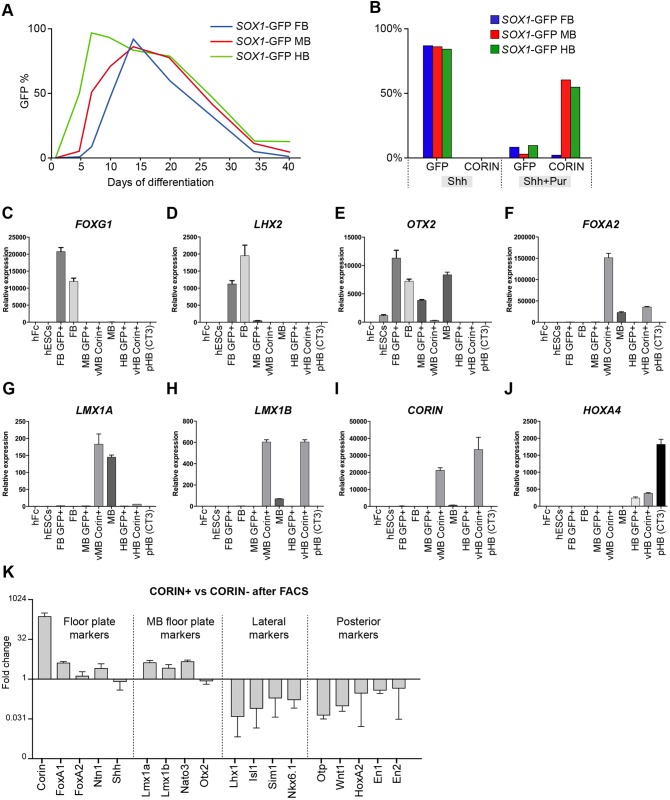
Isolation of purified regionalized human neural progenitor cells. (A) The optimal time point for isolation of early patterned neural progenitors was decided by monitoring the expression of GFP by FACS upon neural differentiation for 40 days. The GFP expression in FB and MB NE cells peaked at day 14, whereas the GFP expression of HB NE peaked already at ∼day 6 and stayed high until terminal differentiation was initiated at day 16. (B) Cells were analysed by FACS at day 14 of differentiation. The vast majority of NE cells express GFP, whereas the FP marker CORIN is absent. In order to ventralize the cells effectively, the SHH agonist Purmorphamine (Pur) was added to the media, in addition to SHH, during day 0-9 of differentiation, resulting in the majority of cells being GFP– at day 14, and FP cells from MB and HB cultures starting to express high levels of CORIN. (C-J) Regionalization of SOX1-GFP ESCs patterned towards FB, MB or HB was investigated at day 14 using qRT-PCR. FB patterning was analysed by the expression of FOXG1, LXH2 and OTX2. MB patterning was analysed by the expression of OTX2, FOXA2 and LMX1A/B. HB patterning was analysed by the expression of HOXA4. The ability to form FP cells was analysed by the expression of CORIN. (K) Isolation of the CORIN+ population from cultures patterned towards ventral MB resulted in enrichment of FP and mesDA markers, whereas cells expressing lateral and posterior markers are excluded. All qRT-PCR analyses were performed using three biological and three technical replicates. Data are presented as mean±s.e.m.